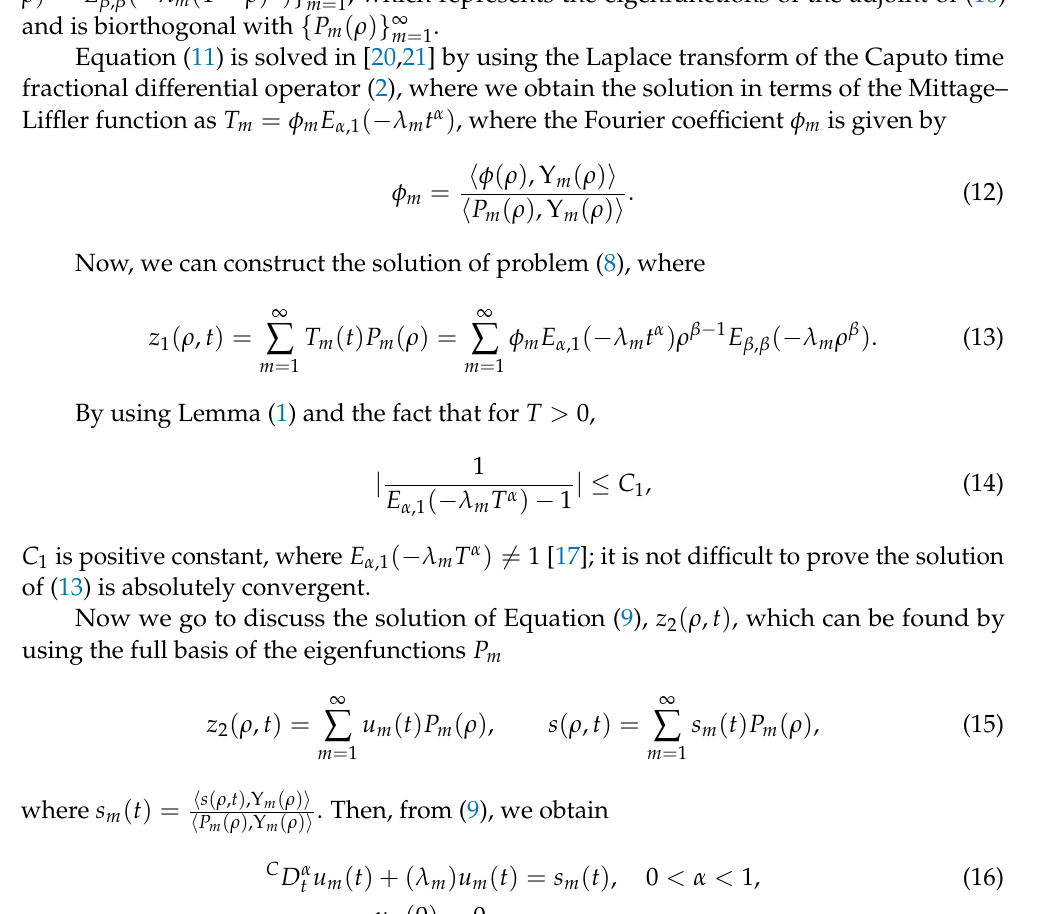
for Equation (10) at β = m = 1